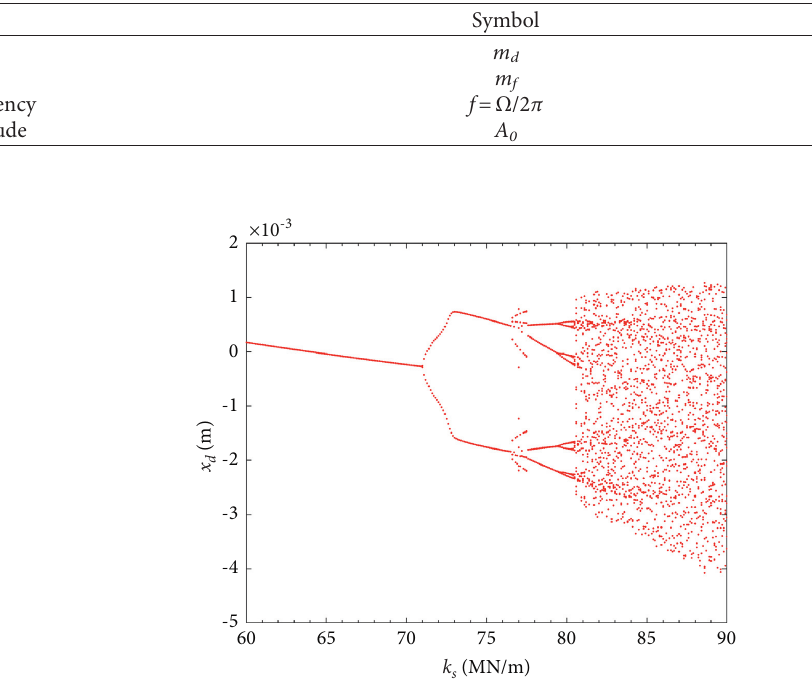
Figure 2: Bifurcation diagram with the subgrade stiffness k